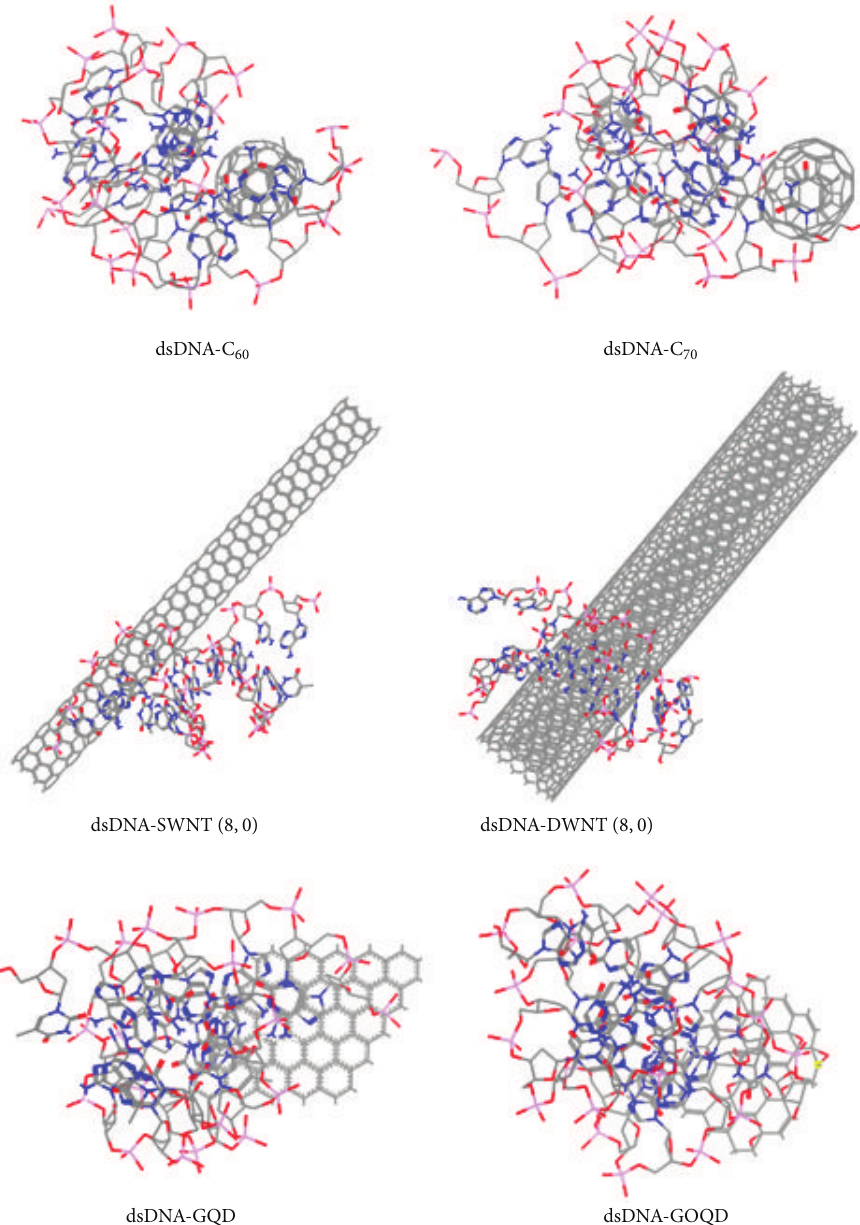
Figure 2: Optimized structures of the dsDNA-CNP